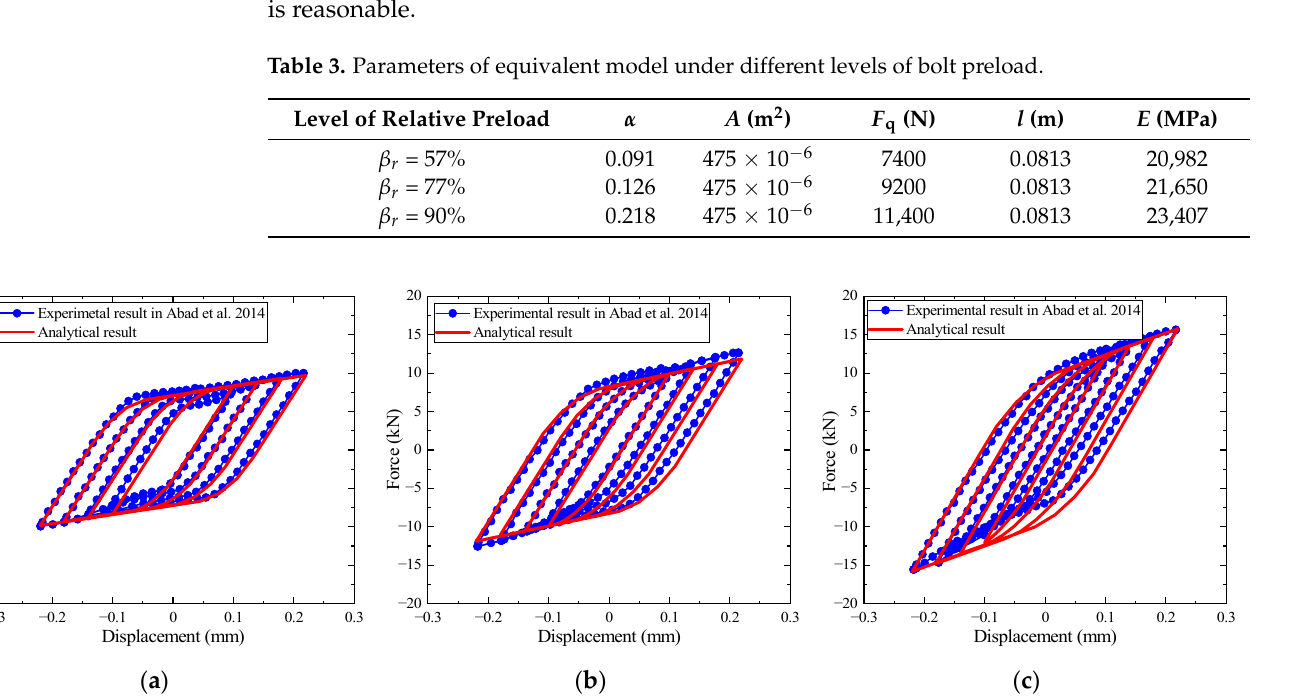
Table 3. Parameters of equivalent model under different levels of bolt preload.